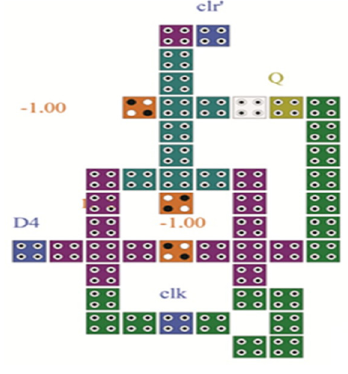
Figure 5. DFF design from [30] .